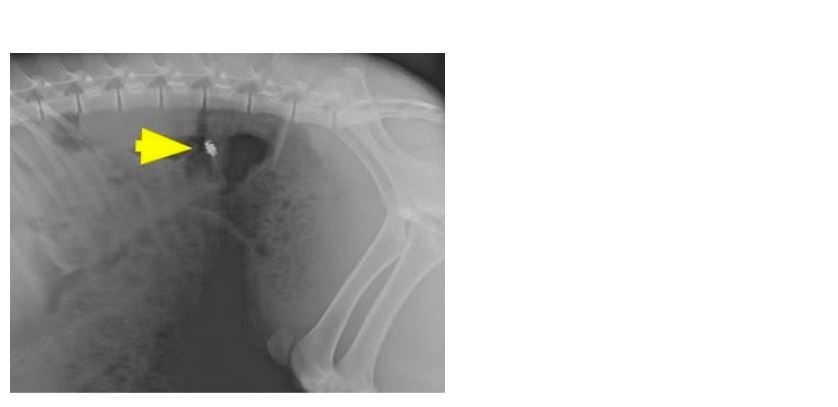
Figure 4. The location of the ingestible capsule, PressureDot, was checked using fluoroscopy. Arrow: the ingestible capsule.